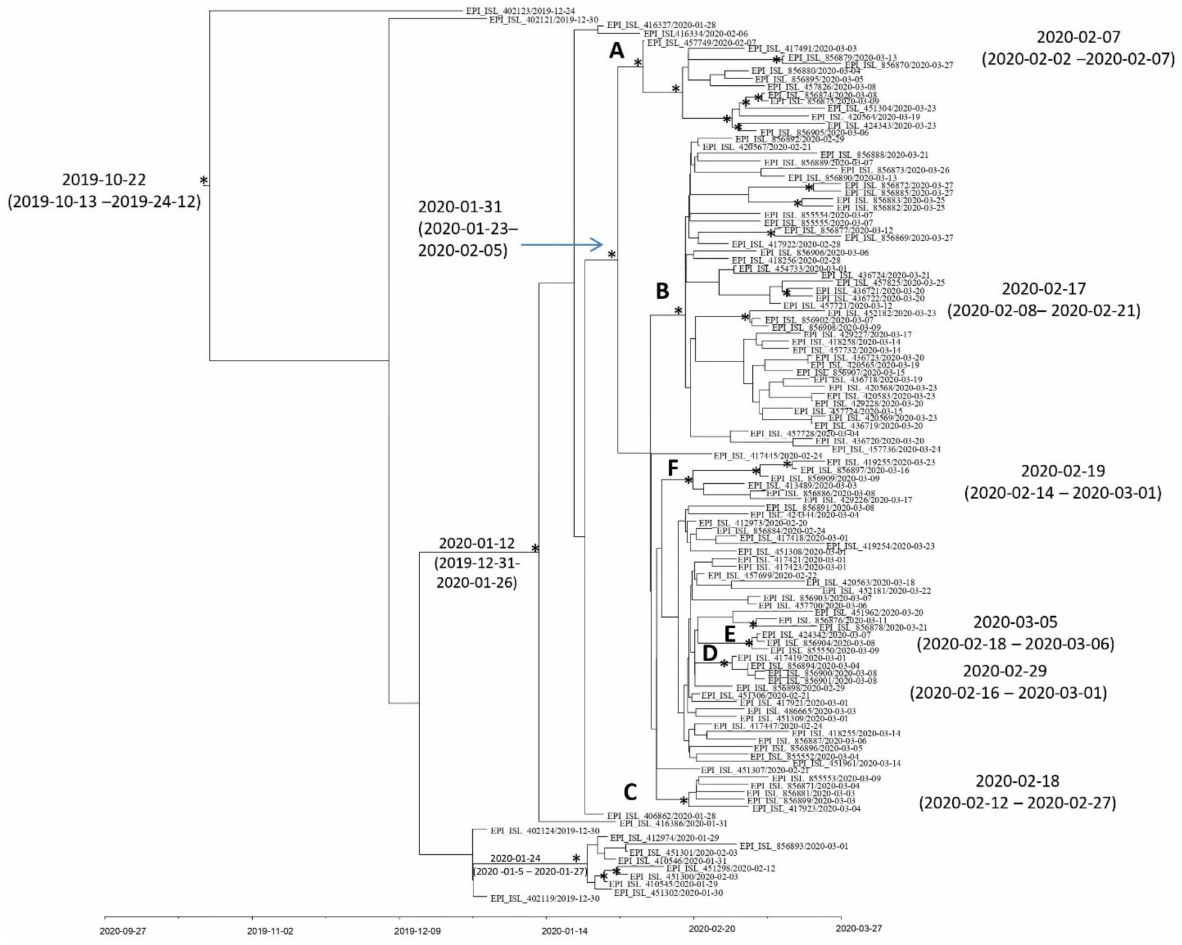
Figure 4. Bayesian maximum clade credibility tree representing the timescale phylogeny and date estimates for the Italian genomes. The asterisk (*) along the branches represents significant statistical support for the clade subtending that branch (posterior probability > 0.80). The scale at the bottom of the tree represents time in dates (year, month, day). Main supported clades are indicated and